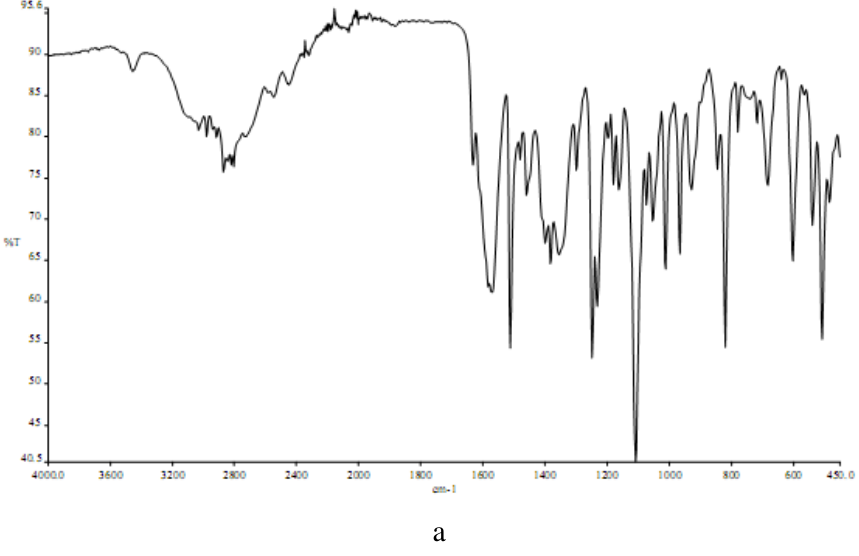
Figure 1. The infrared spectra of: (a) metoprolol tartrate; (b) binuclear MPT-Cu(II) complex; (c) far infrared of binuclear MPT-Cu(II) complex.